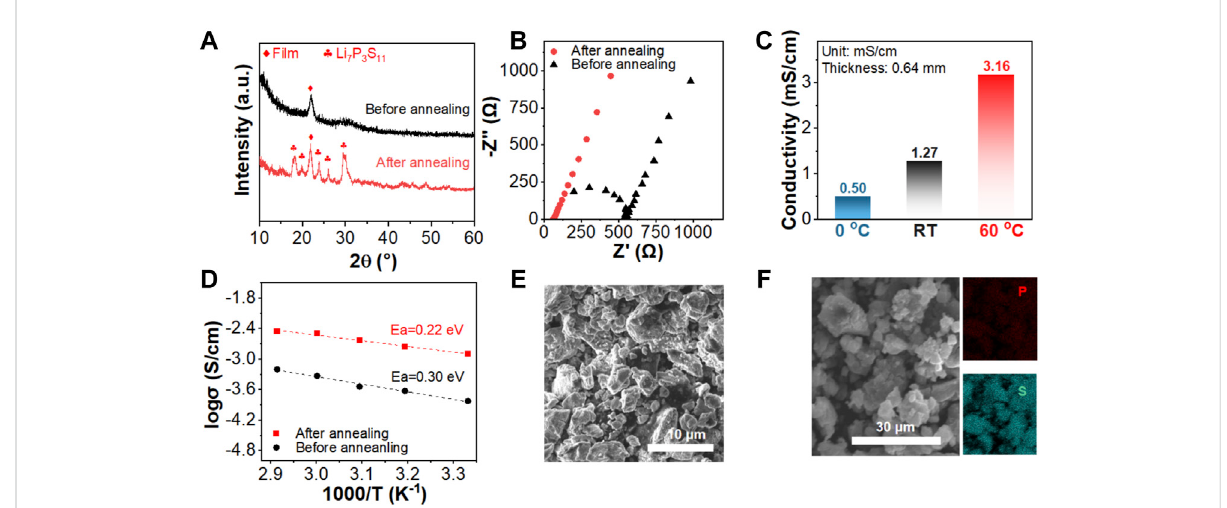
FIGURE 1 (A) XRD patterns of Li (B) the complex Nyquist plots of the Li (C) the 7 P 3 S 11 before and after annealing, 7 P 3 S 11 before and after annealing, corresponding Li-ion conductivity of the prepared Li 7 P 3 S 11 measured at different temperatures (0 ° C, RT and 60 ° C). (D) The corresponding Arrhenius plots of Li 7 P 3 S 11 before and after annealing, (E) SEM images and (F) the EDS mapping images of the sintered Li 7 P 3 S 11